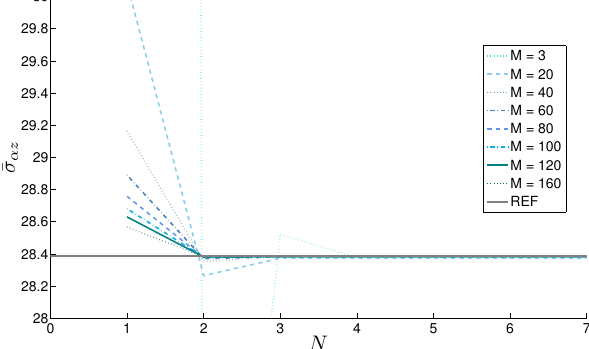
Figure 11. Case 3, sandwich cylindrical shell with FGM ( κ = 2) core and thickness ratio R α / h = 10. Stress ¯ σ α z ( 0, b /2,0 ) vs. N order of expansion of the exponential matrix for different M numbers of global mathematical layers. Reference solution in Brischetto [23] is here indicated as REF. Table 3. Case 3, sandwich cylindrical shell with FGM ( κ = 2) core. Displacement ¯ u for thickness ratio R α / h = 4 and stress ¯ σ α z for thickness ratio R α / h = 10, both evaluated in the middle of the thickness and given as dimensionless values. Three physical layers ( N L = 3) divided into M global mathematical layers. 3D reference solution in Brischetto [23]. Digits given in bold are the correct